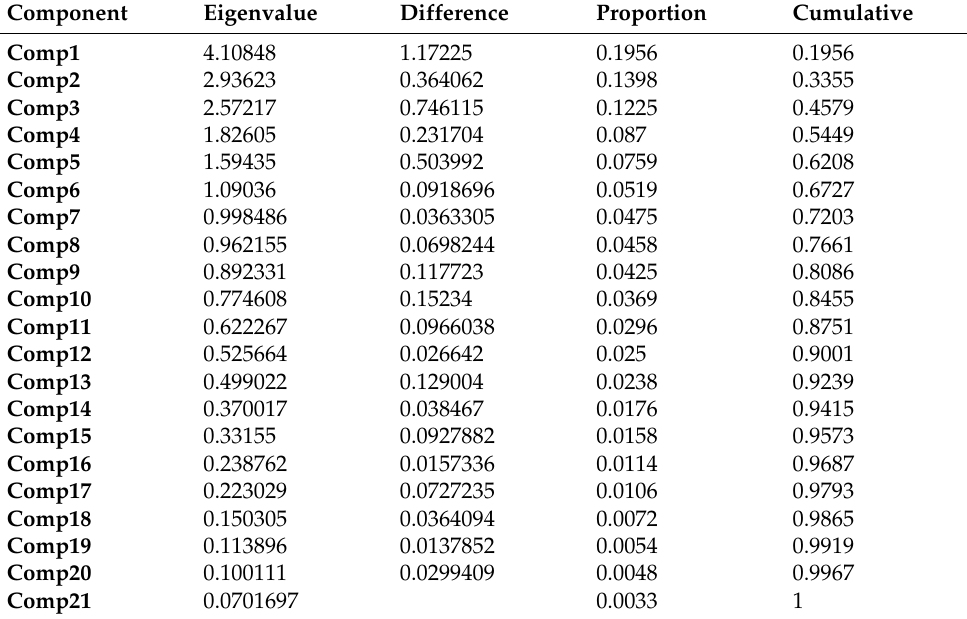
Table A1. The eigenvalues of the components summarised for all the data covering the EU countries.